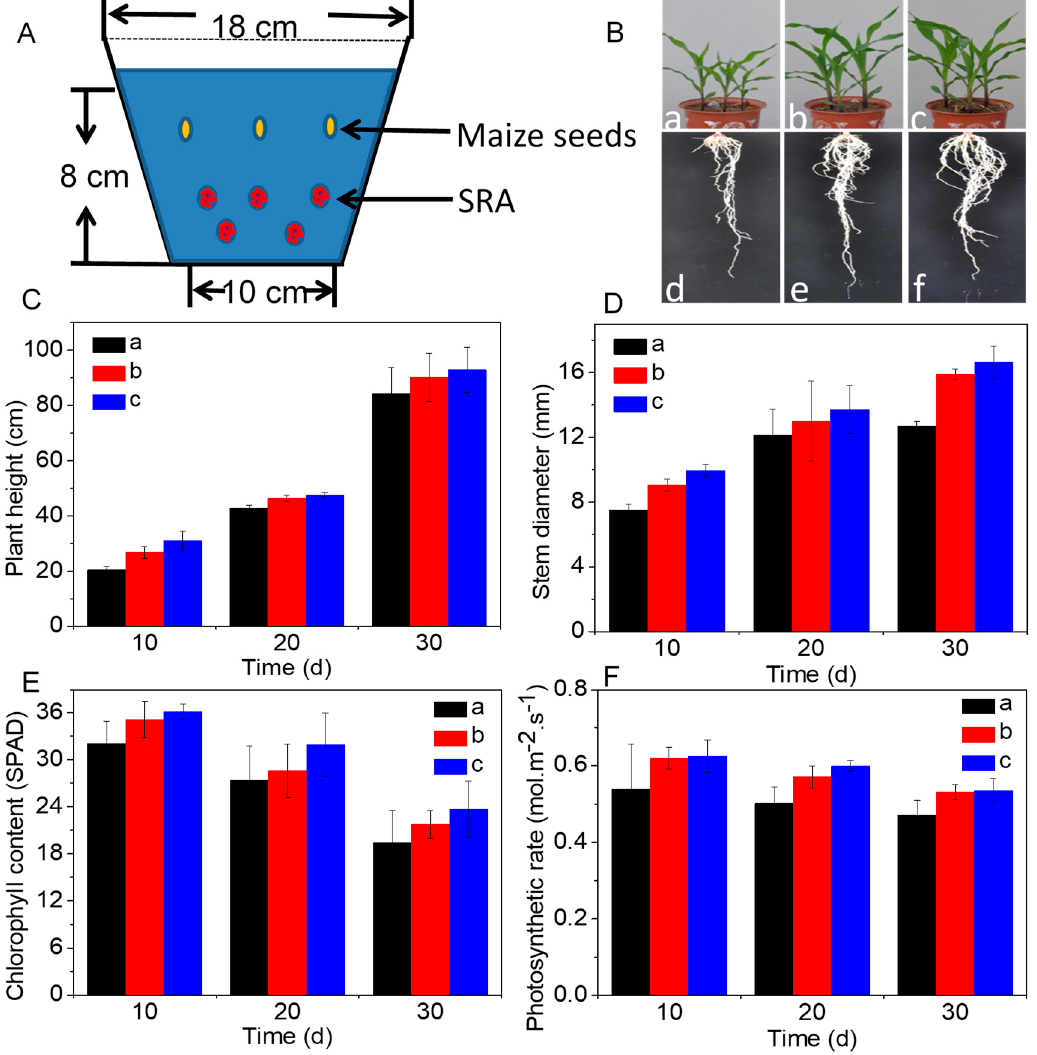
Figure 3. ( A ) Schematic diagram of the pot experiment system. ( B ) Digital photographs of maize